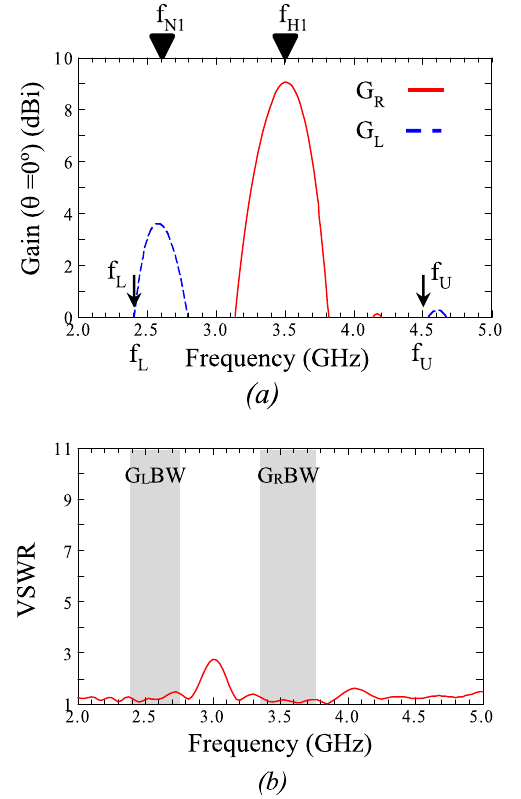
Fig. 20. Frequency response for the square metaloop-C antenna. (a) Gain. (b) VSWR.